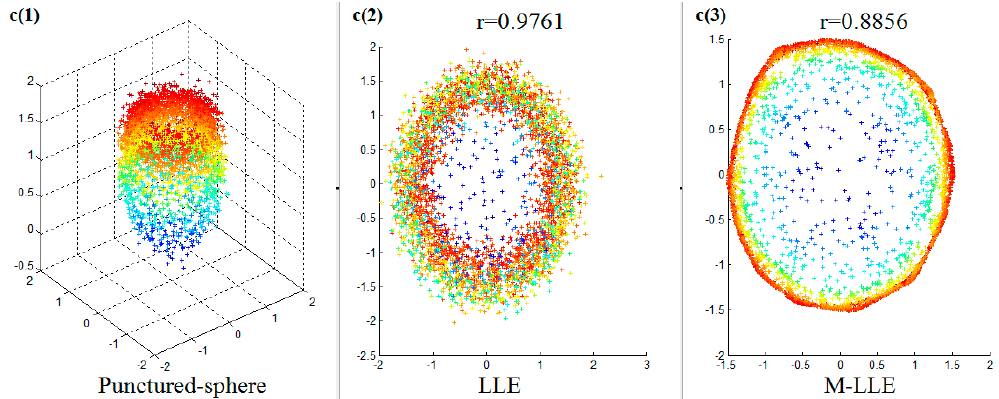
Figure 4. The dimensionality reduction effect of M-LLE algorithm in noisy artificial data set.